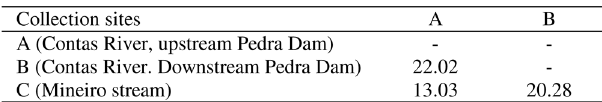
Table 5. Percentage of genetic variability in pairwise compari- sons of Astyanax aff. bimaculatus populations, as estimated by analysis of molecular variance (all values showed statistically significant differences,